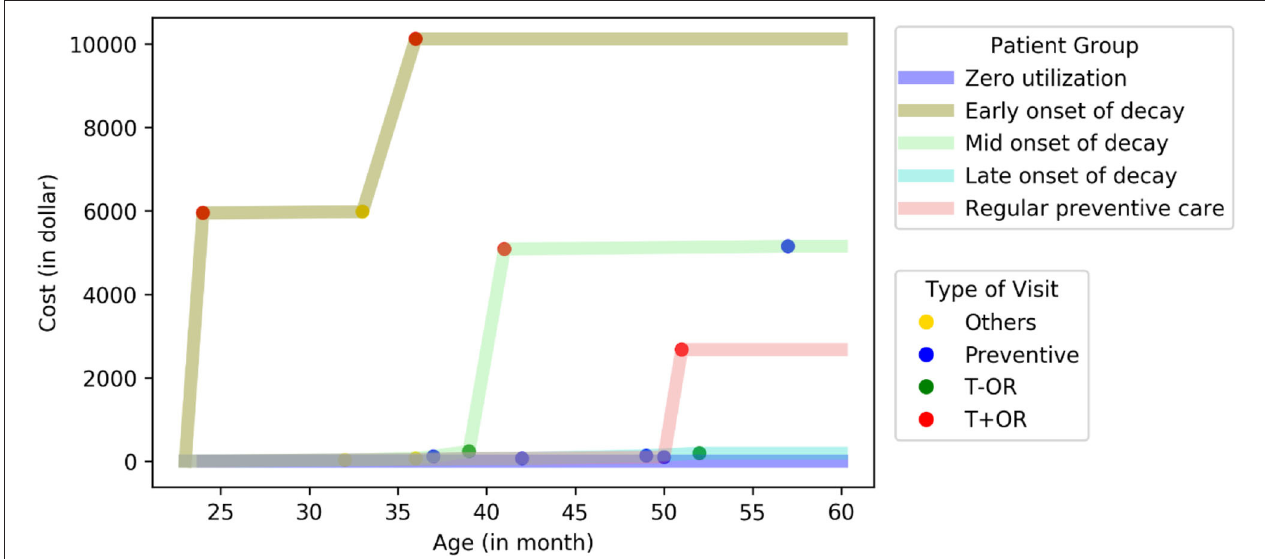
FIGURE 2 | Reproducibility of the five subgroups in an urban subpopulation. A representative patient at the center of each cluster was plotted. (total N =